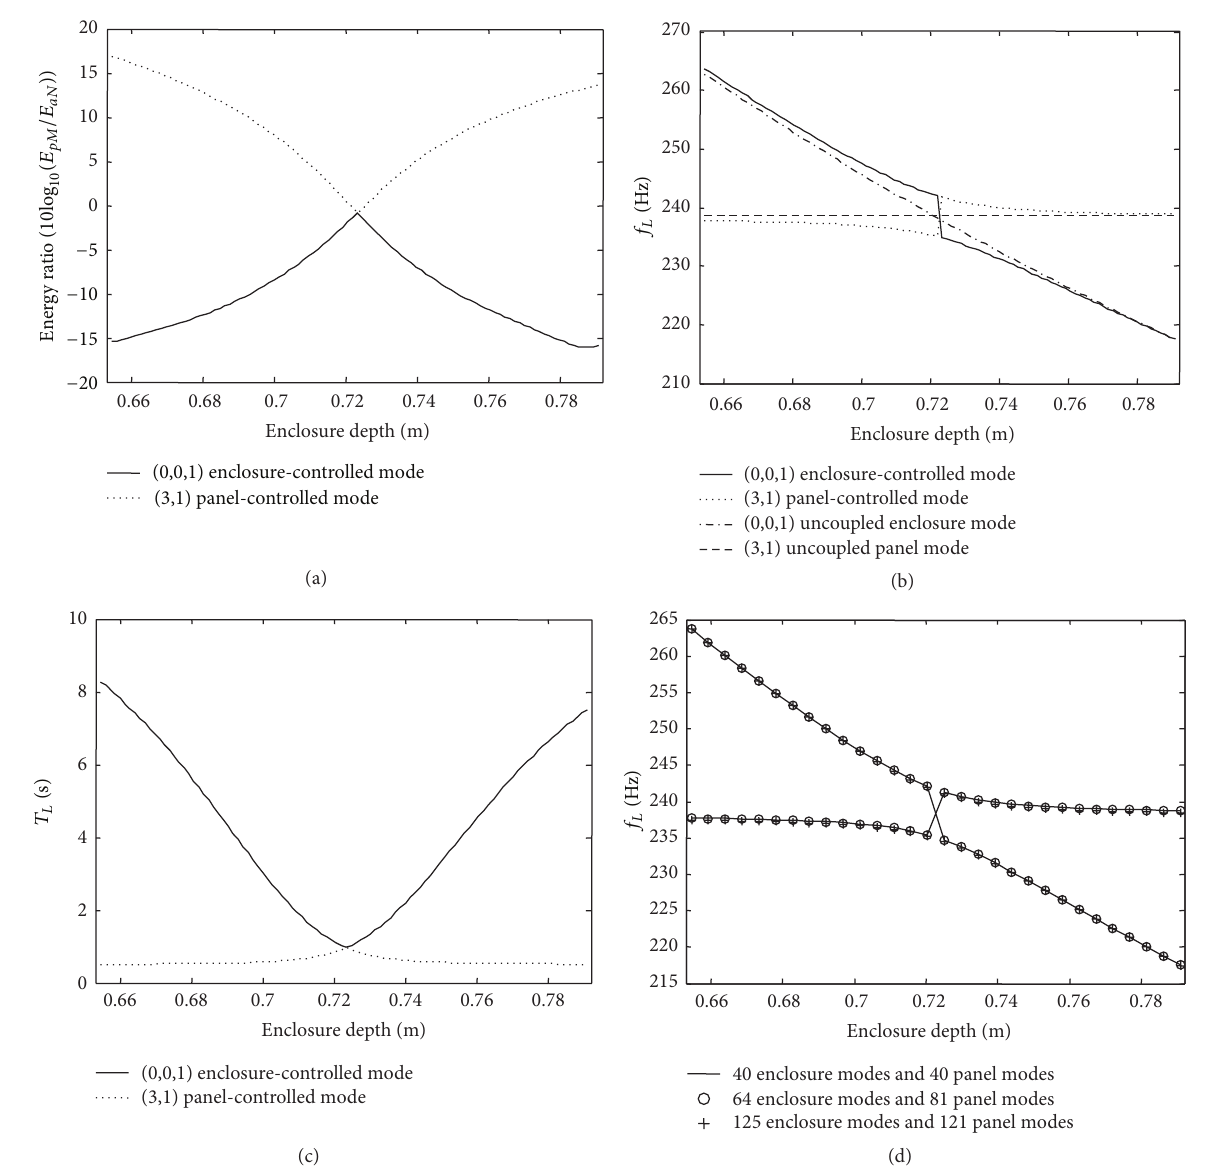
Figure 10: (a) Ratio between the panel vibration energy and sound field energy for two acoustical modes: (0,0,1) enclosure-controlled mode and(3,1)panel-controlledmode.(b)Resonancefrequenciesoftwoacousticalmodes,the(0,0,1)uncoupledenclosuremode,andthe(3,1)panel mode. (c) 60 dB modal decay time 𝑇 𝐿 . (d) Resonance frequencies of two acoustical modes with different truncation numbers. ℎ = 0.007 m, = 15 s, 𝑇 = 0.5 𝑇 𝑎𝑁 𝑝𝑀